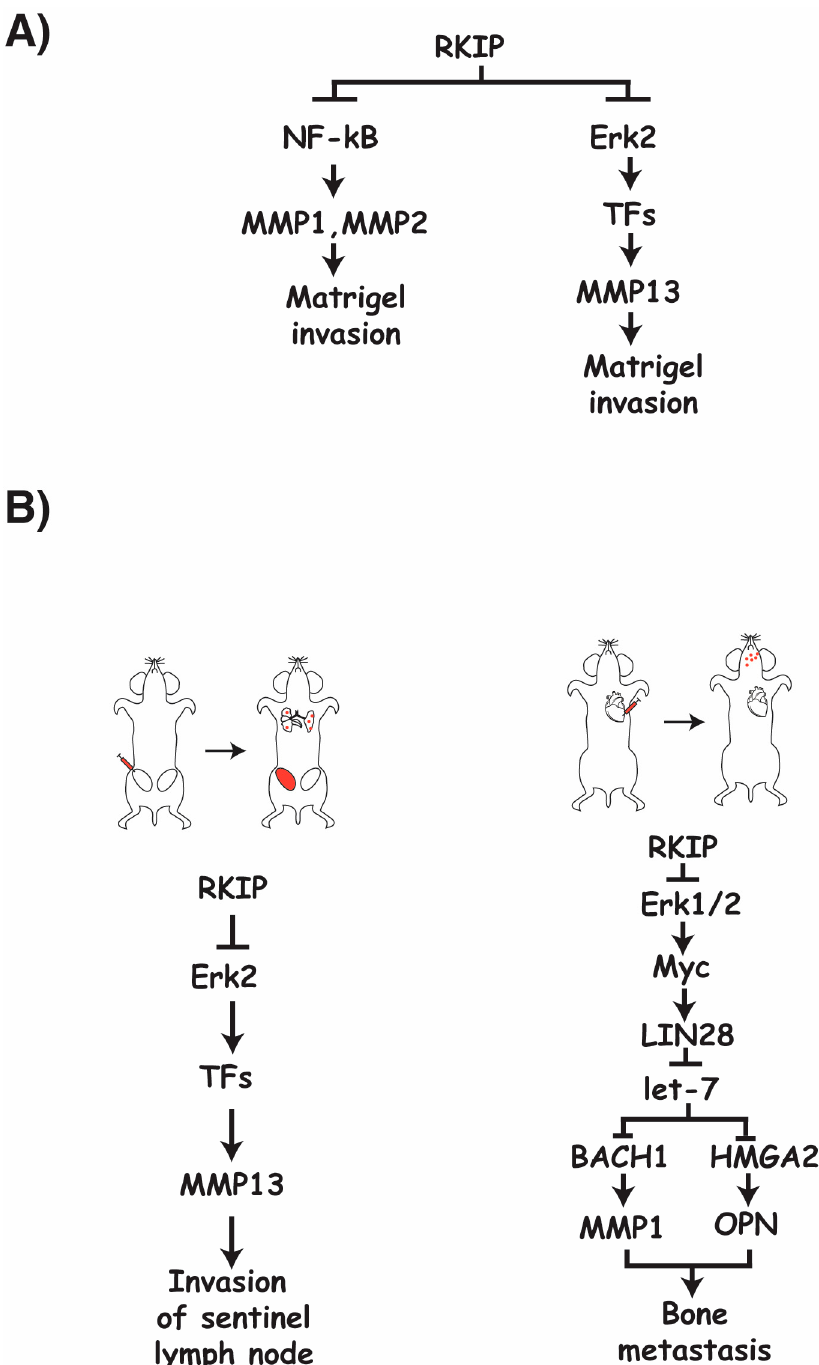
Figure 1. ( A ) A schematic summary of signaling pathways that are targeted by RKIP to regulate the indicated MMP expression in vitro. ( B ) Cartoons showing two different cancer transplantation models used to identify signaling pathways targeted by RKIP to regulate MMP expression in vivo. It is apparent that RKIP suppresses MMP expression through a variety of different pathways, including the Raf/MEK/ERK pathway and the NF-kB pathway (Figure 1A).